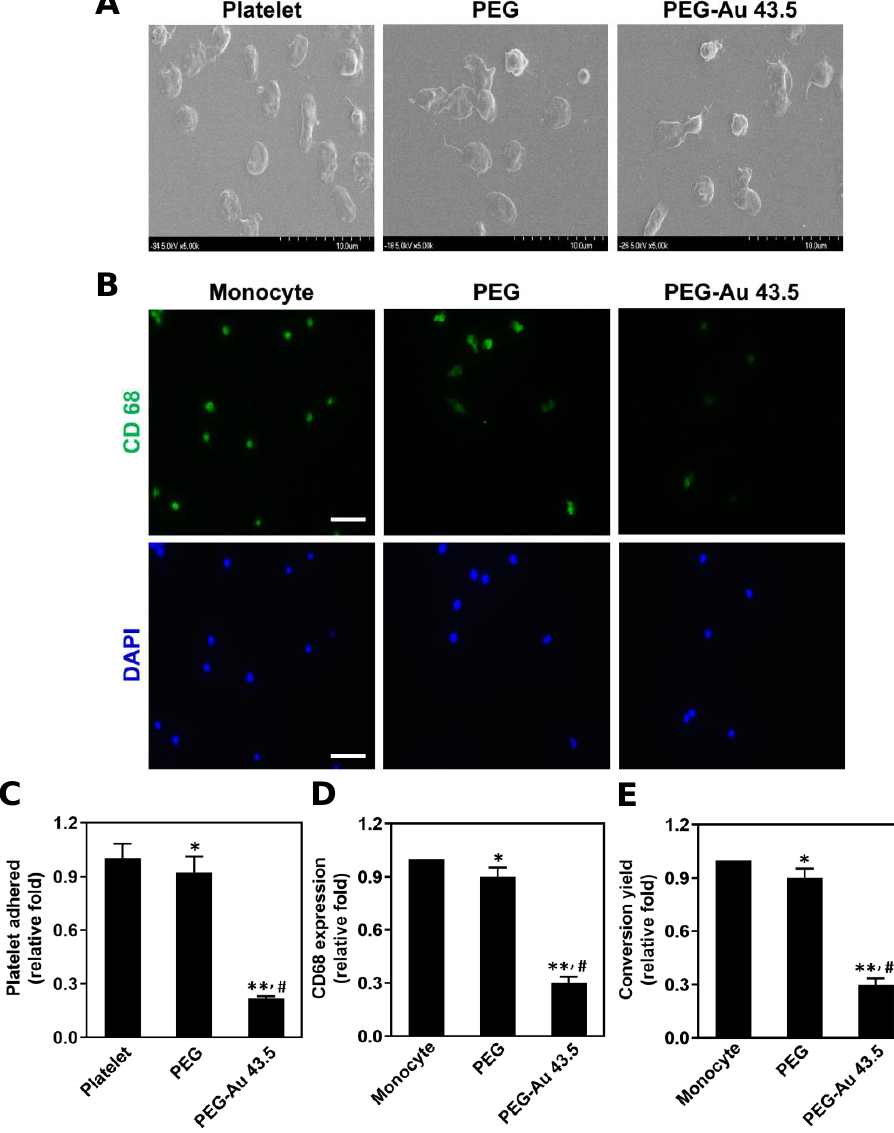
Figure 3. Assessments of platelet activation and monocyte conversion induced by pure PEG and PEG containing 43.5 ppm of Au at 96 h. ( A ) Images of SEM demonstrated the adhesion and activation of human blood platelets in different materials. ( B ) The expression of CD68 for macrophages on various materials at 96 h. The cells were immunostained by primary anti-CD68 antibodies and conjugated with FITC — immunoglobin secondary antibodies (green color). Cell nuclei were stained by a DAPI solution (blue color). Scale bar = 20 μ m. ( C ) The data quantified from the degree of activation score indicated that PEG – Au 43.5 ppm could inhibit platelets to adhere. ( D ) The semi-quantitative results of CD68 expression based upon fluorescence intensity. ( E ) The monocyte conversion yield demonstrated that PEG – Au 43.5 ppm would not stimulate the activation of monocytes and better attenuate immune response. Data are displayed as mean ± SD (n = 3). * p < 0.05, ** p < 0.01: compared to the platelet/monocyte alone group. # p < 0.05: compared to the pure PEG group.